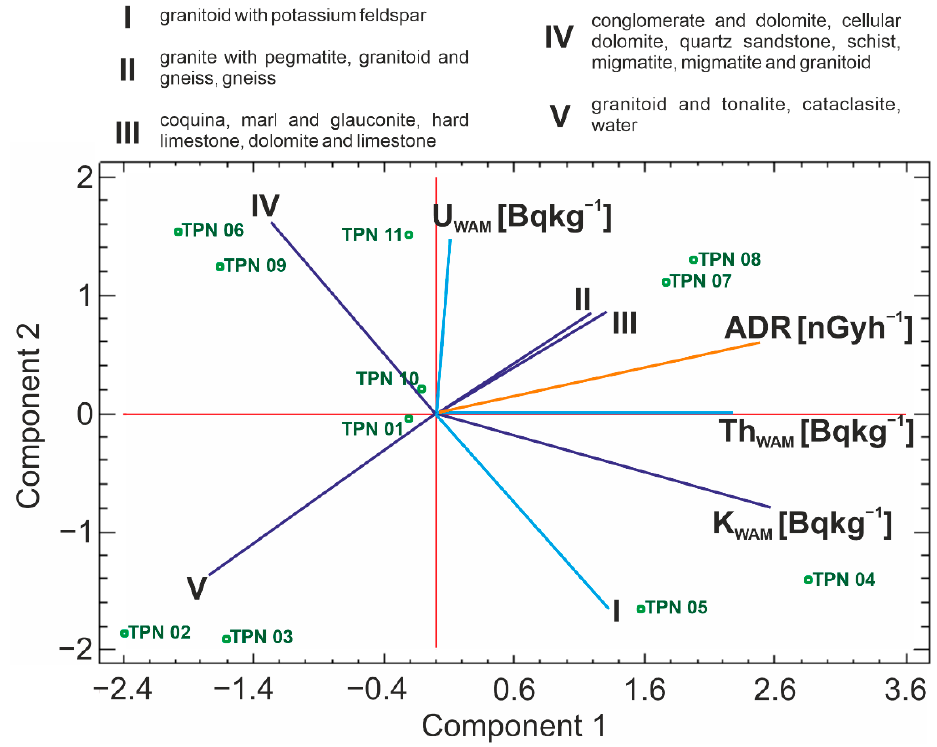
Figure 9. Biplot—Principal Component Analysis.